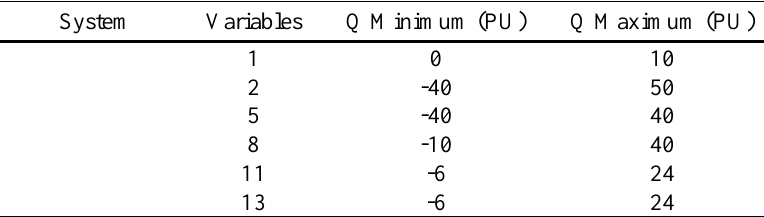
Table 5. Constrains of reactive power generators.